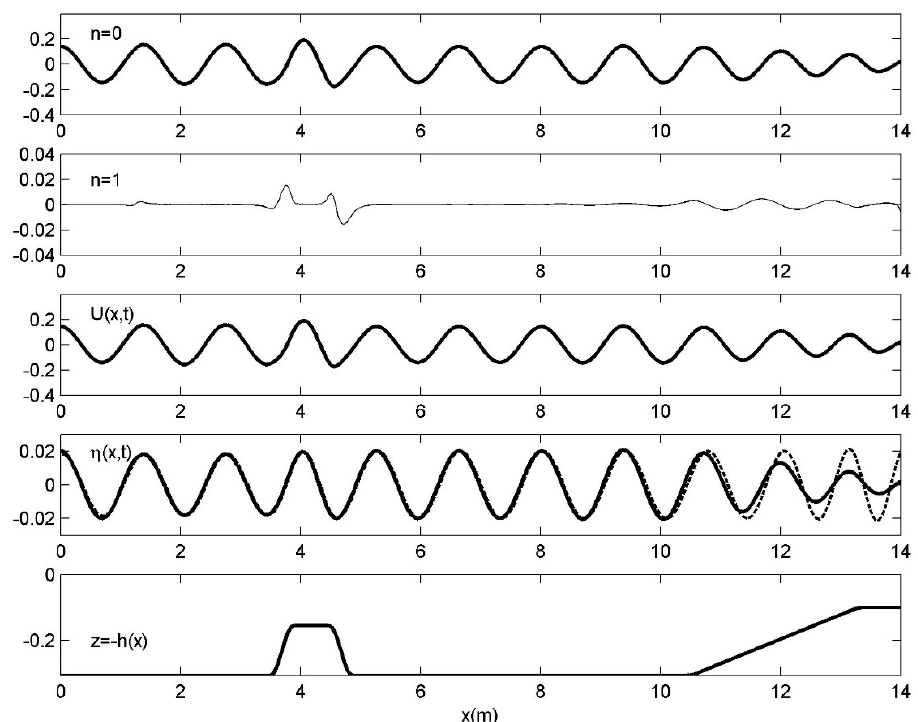
Figure 9. Results obtained by the present CMS for harmonic incident waves of period T = 1 s propagating over the trapezoidal bar of Figure 8 without current. The last three subplots show (using thick lines) the free-surface velocity field U ( x , z = 0; t ) and the free surface elevation η ( x ; t ) at the same instant, and finally the sloping bottom topography. The time-harmonic solution [17] is indicated by using dashed lines.